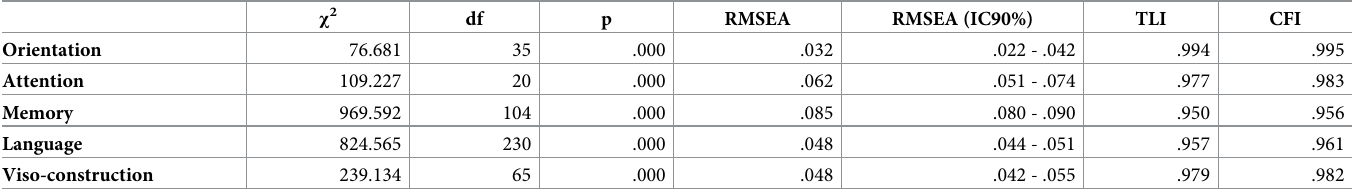
Table 1. Goodness of fit indices of each subscale to the unidimensional model (AFC). χ 2 df